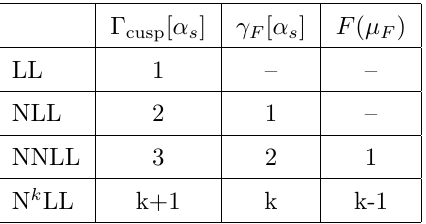
Table 2 . The loop order at which the various pieces ingredients to the RGE need to be computed to reach a given level in resummation